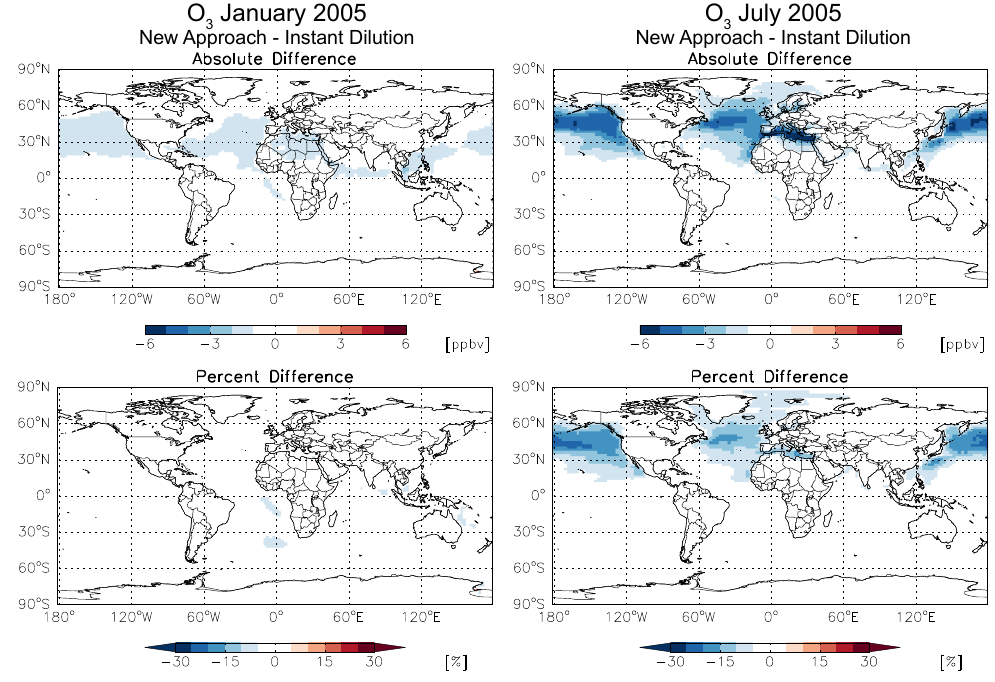
Fig. 7. Differences between instant dilution and plume-in-grid simulations of O 3 concentrations in January and July 2005. Results are Fig. 7. Difference plots between monthly mean global O 3 concentrations simulated with GEOS-Chem shown for the lowest GEOS-Chem model layer for January and July 2005 for the instant diluting model and the new LUT approach model simulations, for the lowest model layer (0–0.12 km).